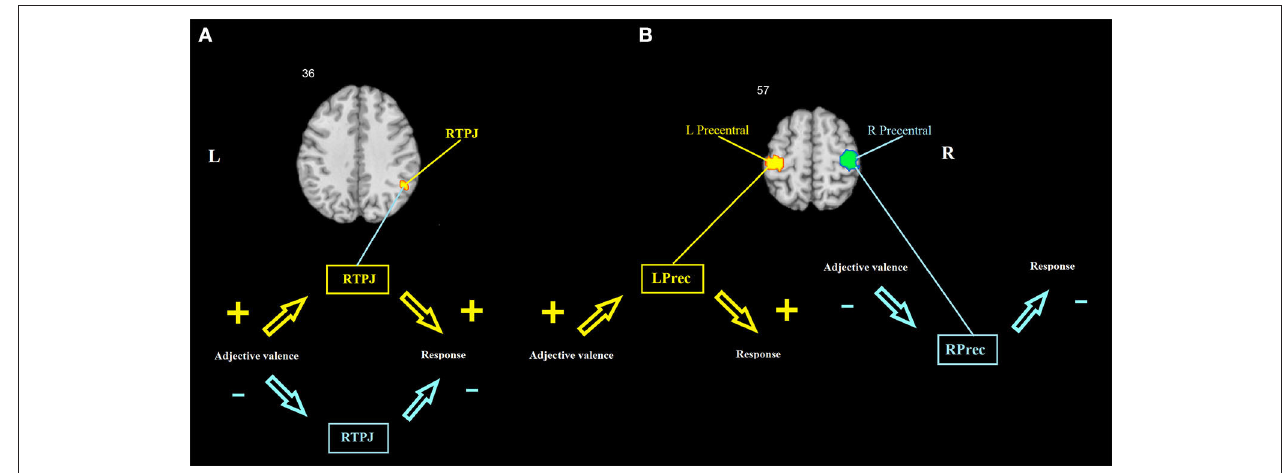
FIGURE 3 | Brain mediators of the relationship between adjective valence and behavioral response. (A) The right TPJ shows a mediation effect that is driven by the covariance between a and b coefficients across individuals. (B) The left and right precentral gyri show mediation effects that are driven by consistent effects. Hot colors show a positive association between adjective valence and brain activity, and between brain activity and behavioral response. Cool colors show a negative association between adjective valence and brain activity, and between brain activity and behavioral response. RTPJ, right temporoparietal junction; LPrec and RPrec, left and right precentral